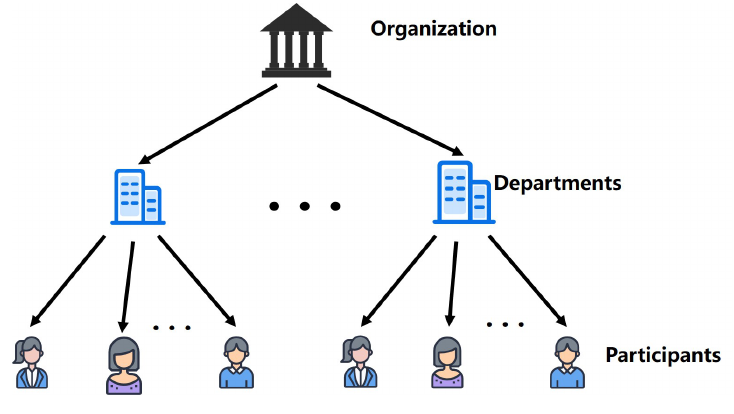
Figure 1. System